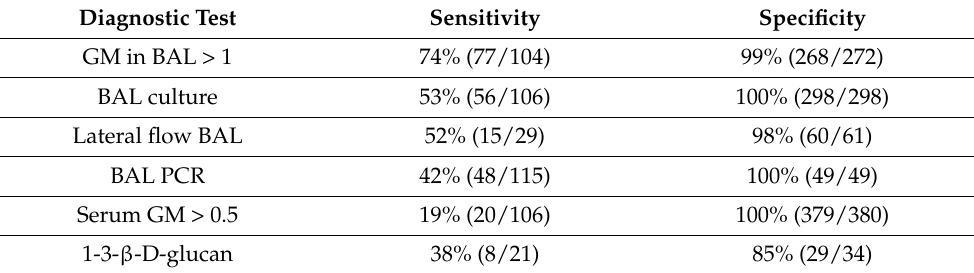
Table 2. Validation of Mycological Tests in Multi-Center Studies of CAPA Patients